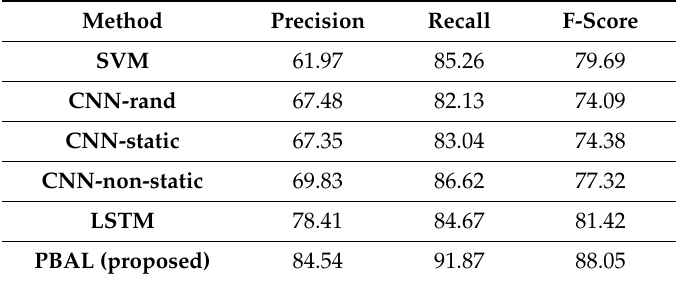
Table 8. Experimental results on test dataset 2.